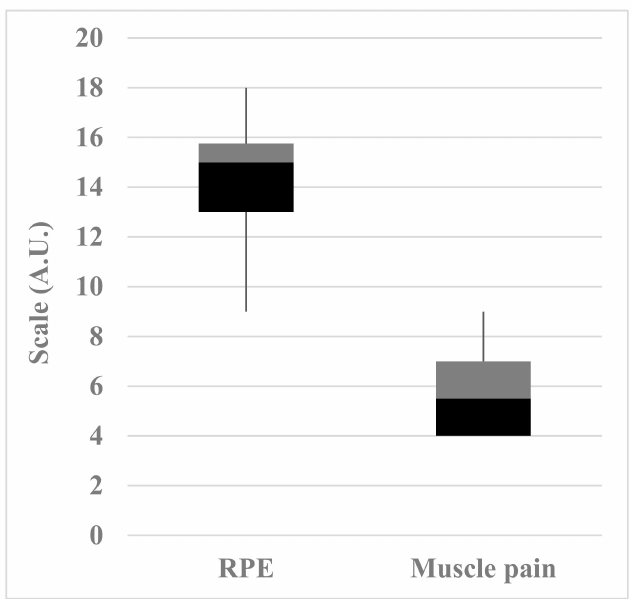
Figure 1. Rating of perceived exertion (RPE) and muscle pain intensity scales of marathon runners at the end of competition. The lower, middle, and upper lines of the box represent the 25th, 50th, and 75th percentiles. Whiskers represent range. A.U.: arbitrary